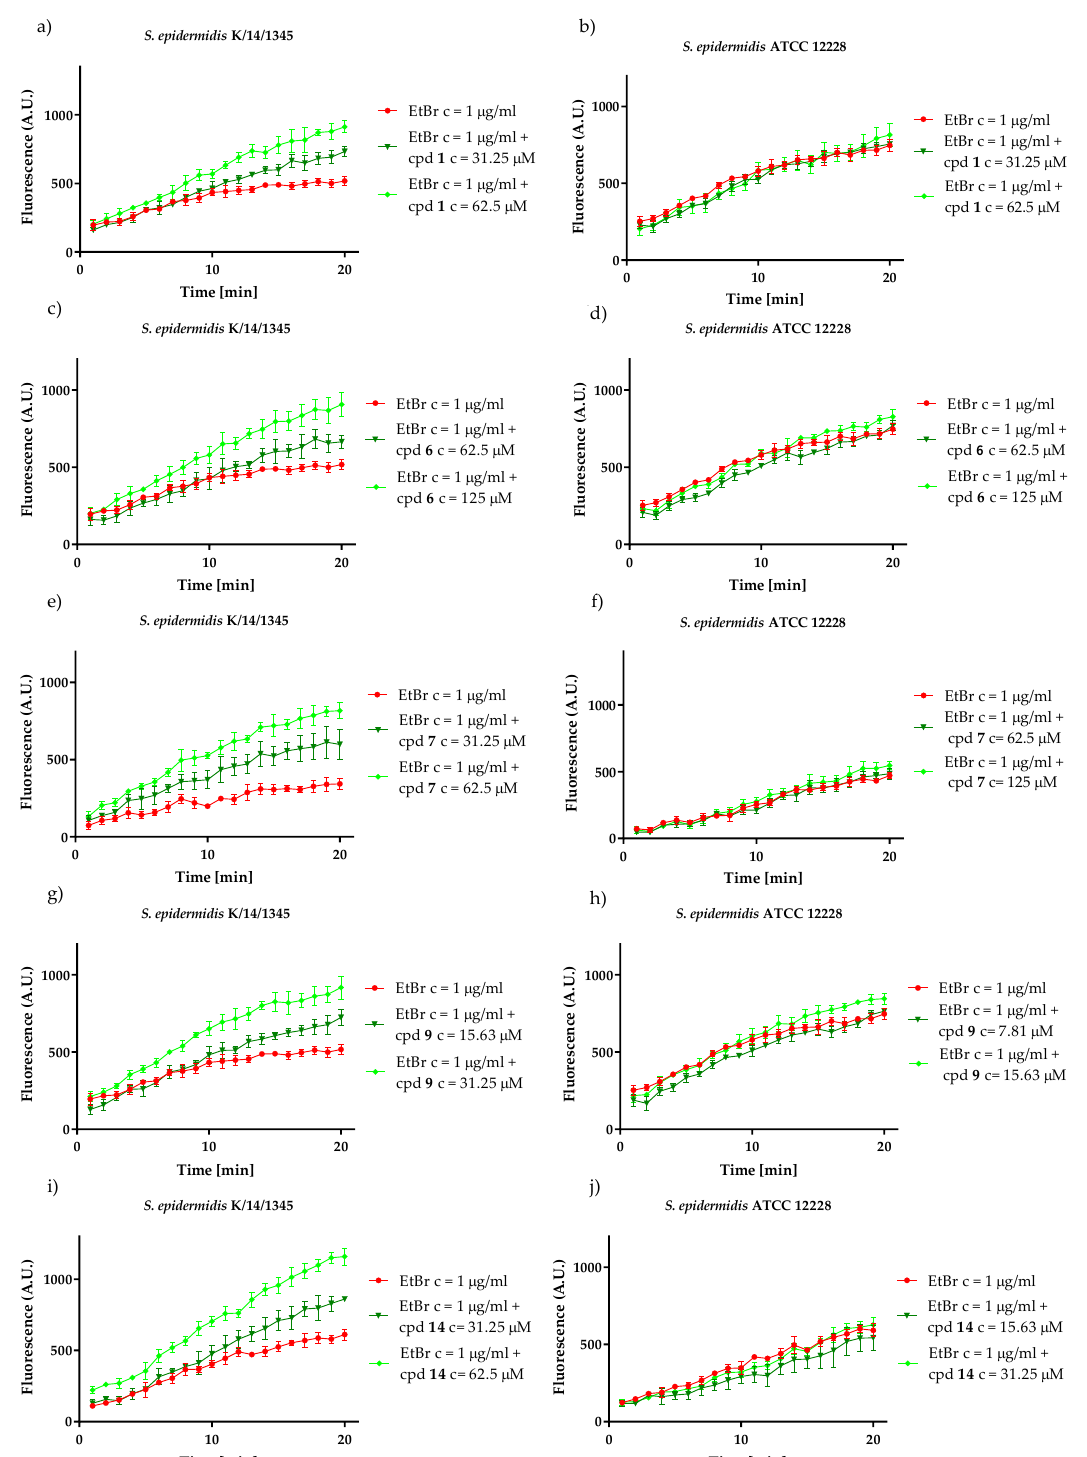
Figure 2. Influence of compounds 1 ( a , b ), 6 ( c , d ), 7 ( e , f ), 9 ( g , h ) and 14 ( i , j ) tested at the concentrations corresponding to 1 / 4 and 1 / 2 of their MIC values on the accumulation of EtBr (1 µ g / mL) in Msr(A)-overexpressing S. epidermidis strain K / 14 / 1345 and Msr(A)-deficient S. epidermidis strain ATCC 12228. Each data point expresses the mean ± standard deviation (SD) from four